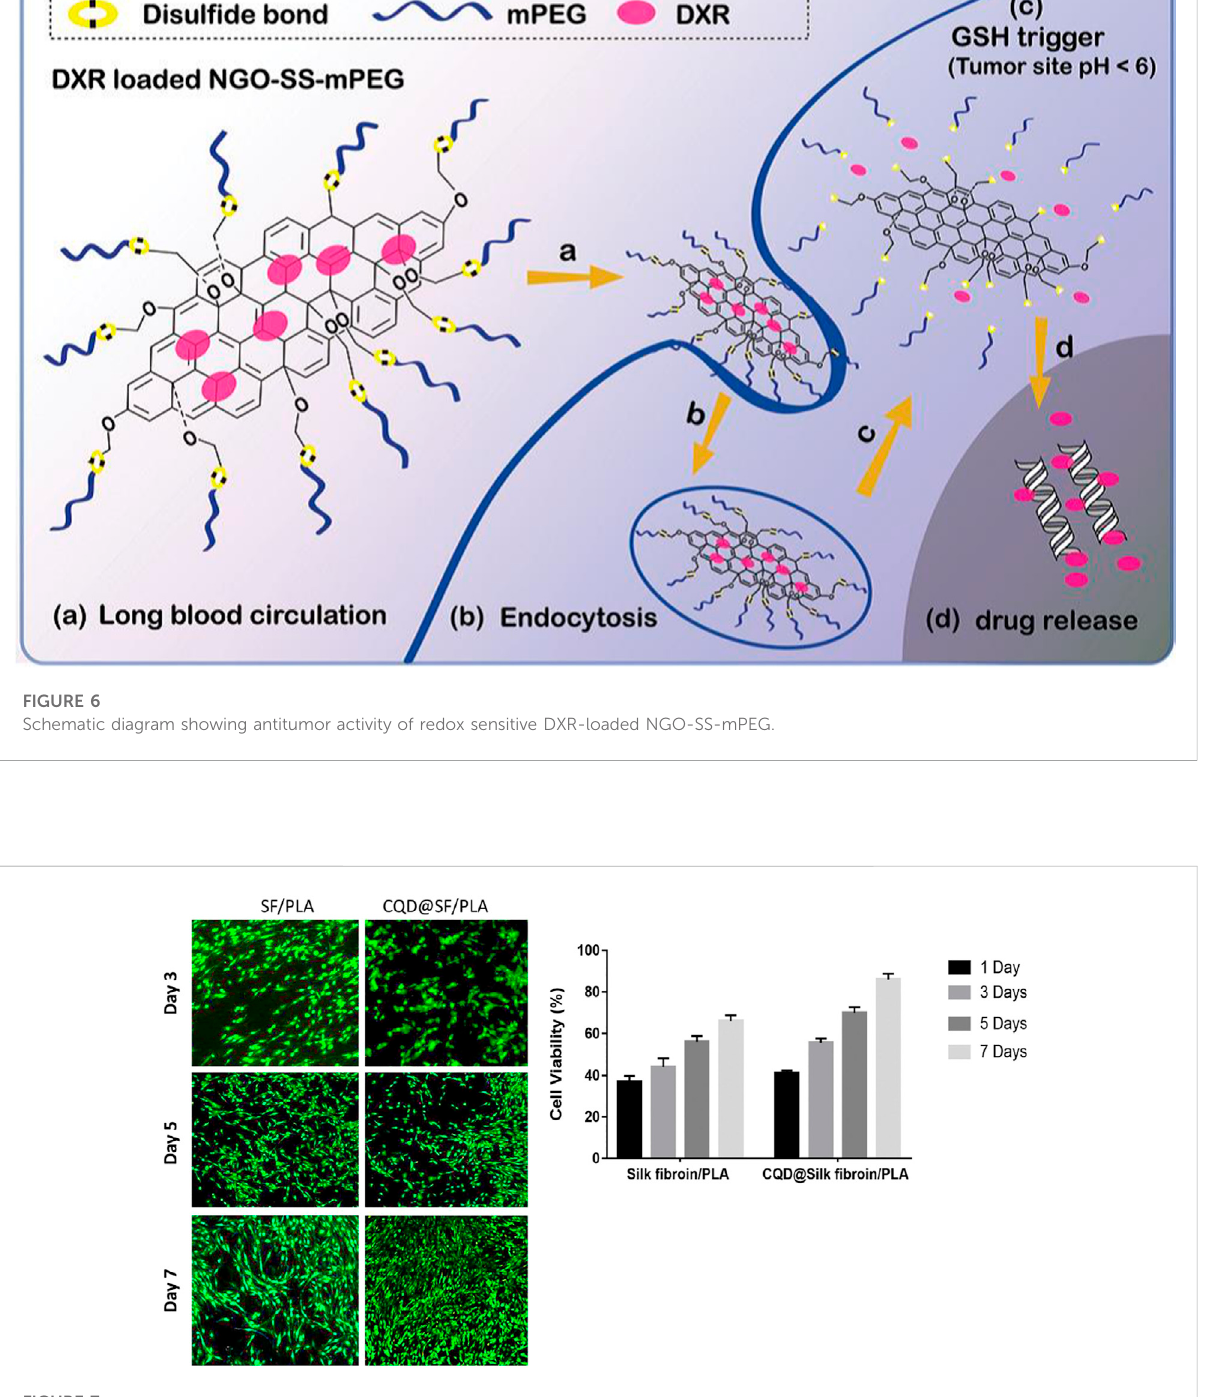
FIGURE 7 Invitro fl uorescencecellviabilityimagesandQuanti fi edcellviabilityoftheSilk fi broin/PLAinthepresenceandabsenceofCQDnanoparticlesat 1, 3, 5, and 7 days of